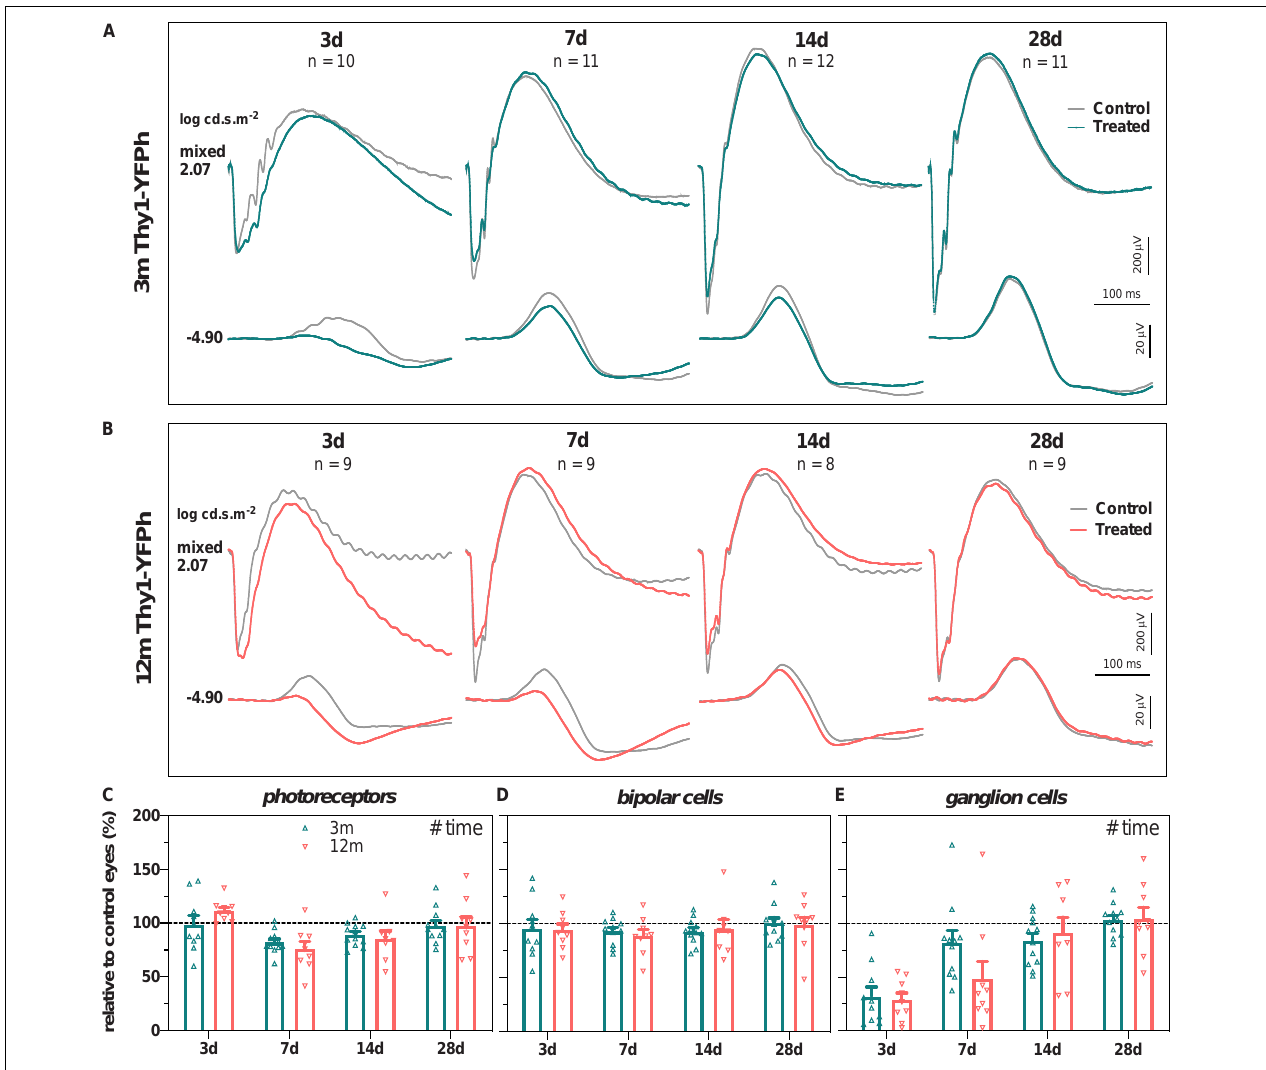
FIGURE 3 | Recovery of retinal function in 3- and 12-month-old Thy1-YFPh mice. (A) Group averaged ERG waveforms in 3-month-old mice (teal traces, treated eyes; gray traces, control eyes) at luminous energies representing predominantly ganglion cell responses (–4.90 log cd.s.m − 2 ) and outer retinal function (2.07 log cd.s.m − 2 ) at 3 ( n = 10), 7 ( n = 11), 14 ( n = 12), and 28 days ( n = 11). (B) Group averaged ERG waveforms in 12-month-old mice (orange traces, treated eyes; gray traces, control eyes) at 3 ( n = 9), 7 ( n = 9), 14 ( n = 8), and 28 days ( n = 9). (C–E) ERG responses from IOP-treated eyes expressed relative to their contralateral control eyes for (C) photoreceptor amplitude, (D) bipolar cell amplitude, and (E) ganglion cell amplitude (pSTR) in 3-month-old (teal bars) and 12-month-old (orange bars) mice. Error bars, SEM; #, two-way ANOVA p <